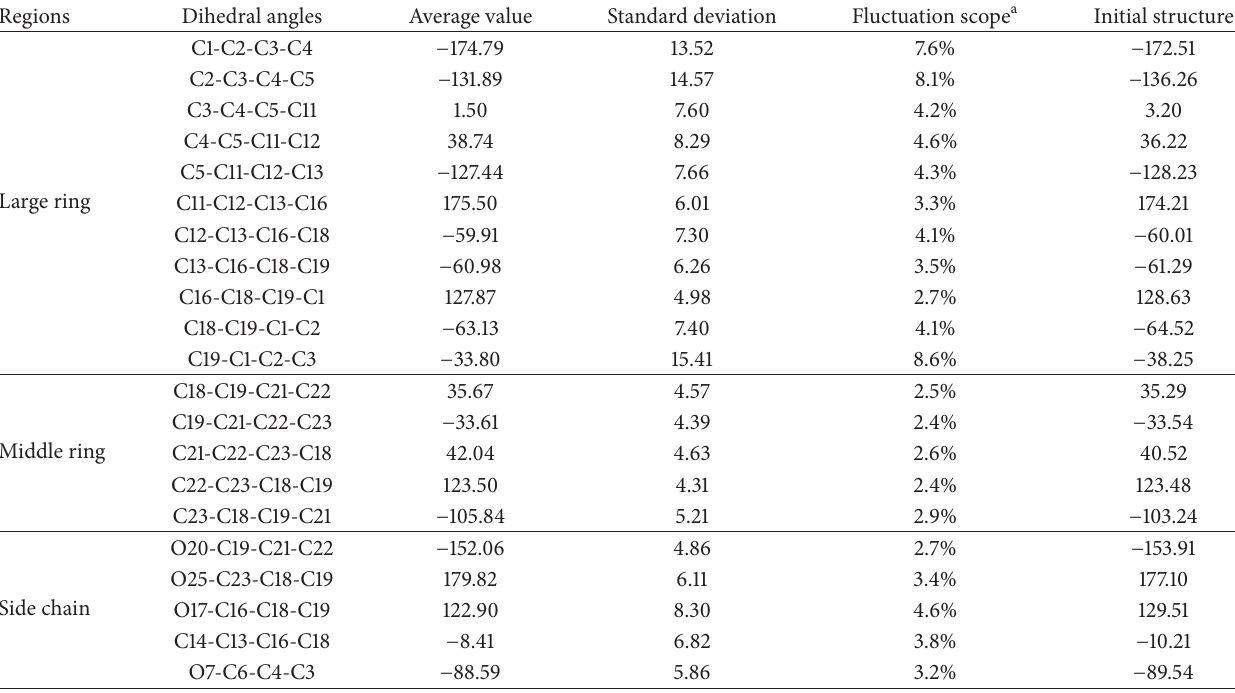
Figure 8: The refined binding mode between L713283 and 𝛽 -tubulin. (a) The L713283 and key residues are shown in stick model. The four key residue regions are depicted with C 𝛼 -wire model in green, blue, orange, and purple. The polar types of each eight amino acids are shown in the corresponding rectangles. ( − ), (0), and (+) are used to represent the amino acids in negative, nonpolar, and positive charges, respectively. (b) The electrostatic potential map of the active pocket of 𝛽 -tubulin. L713283 is shown in green stick model. The regions of positive and negative charges are, respectively, colored in blue and red. Table 2: The dihedral angle information of both rings and side chains for L713283